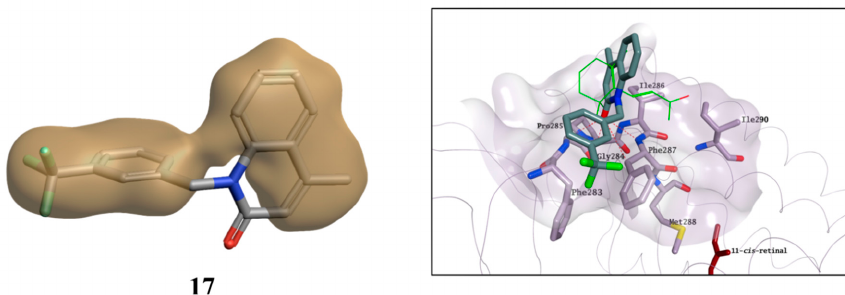
Figure 14. Hydrophobic region for 17 and its potential binding mode on the secondary pocket. The compound presents two hydrophobic areas, which are not coplanar. β -ionone carbon atoms are in green. The binding site area is represented as molecular surface. Rhodopsin is represented as the lilac tube for clarity.